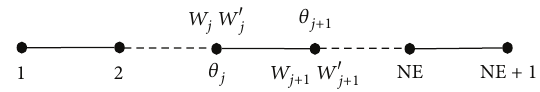
Figure 2: Discretized domain along the beam